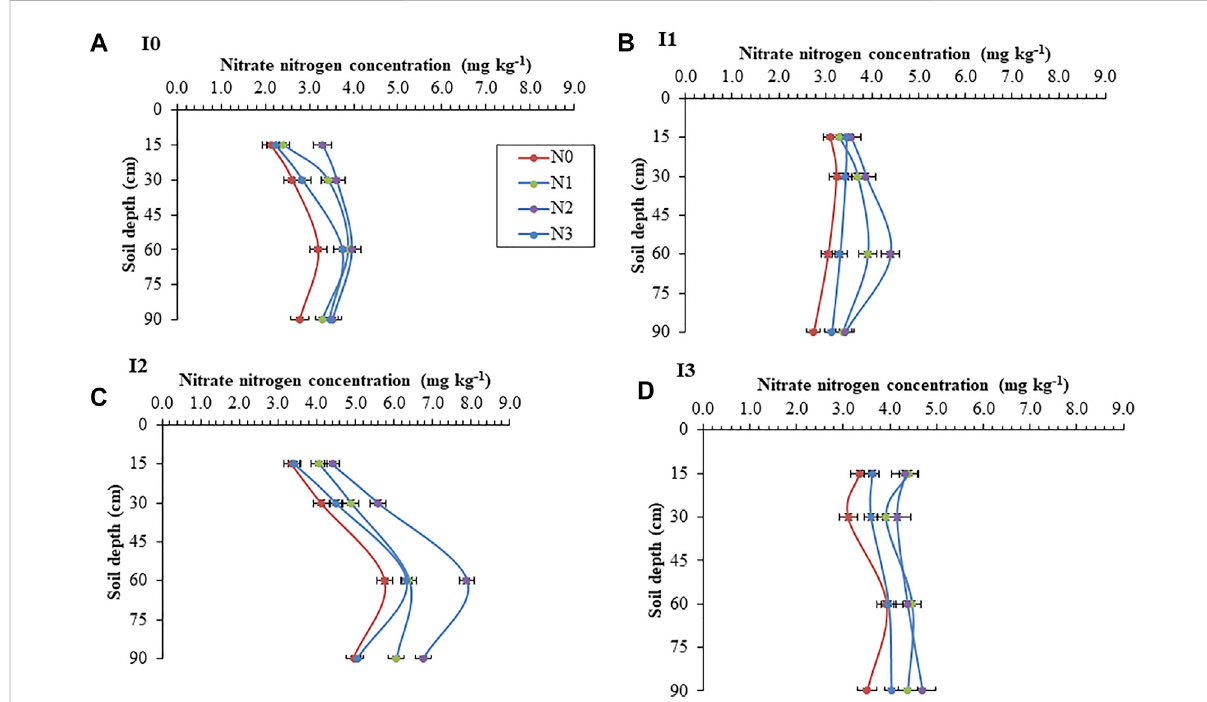
FIGURE 11 Effect of different irrigation regimes and nitrogen levels on the nitrate-nitrogen accumulation in the soil pro fi le (0 – 90 cm) after the harvest of wheat crops (pooled analysis) (means of similar lowercase letters are not signi fi cant at p < 0.05 based on DMRT).